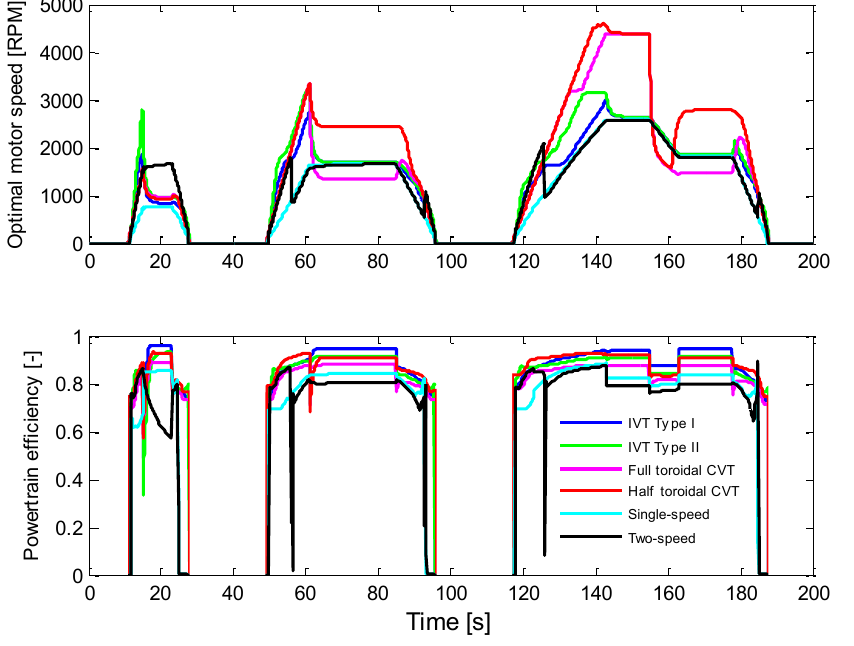
Figure 15. Optimal motor speed and powertrain efficiency as a function of time.